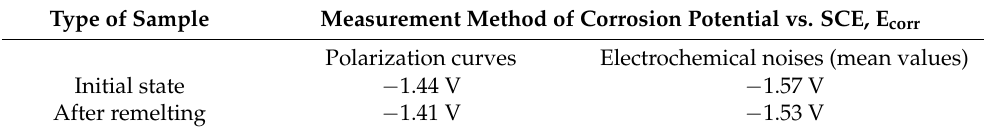
Table 4. Comparative list of corrosion potential values determined by different measurement